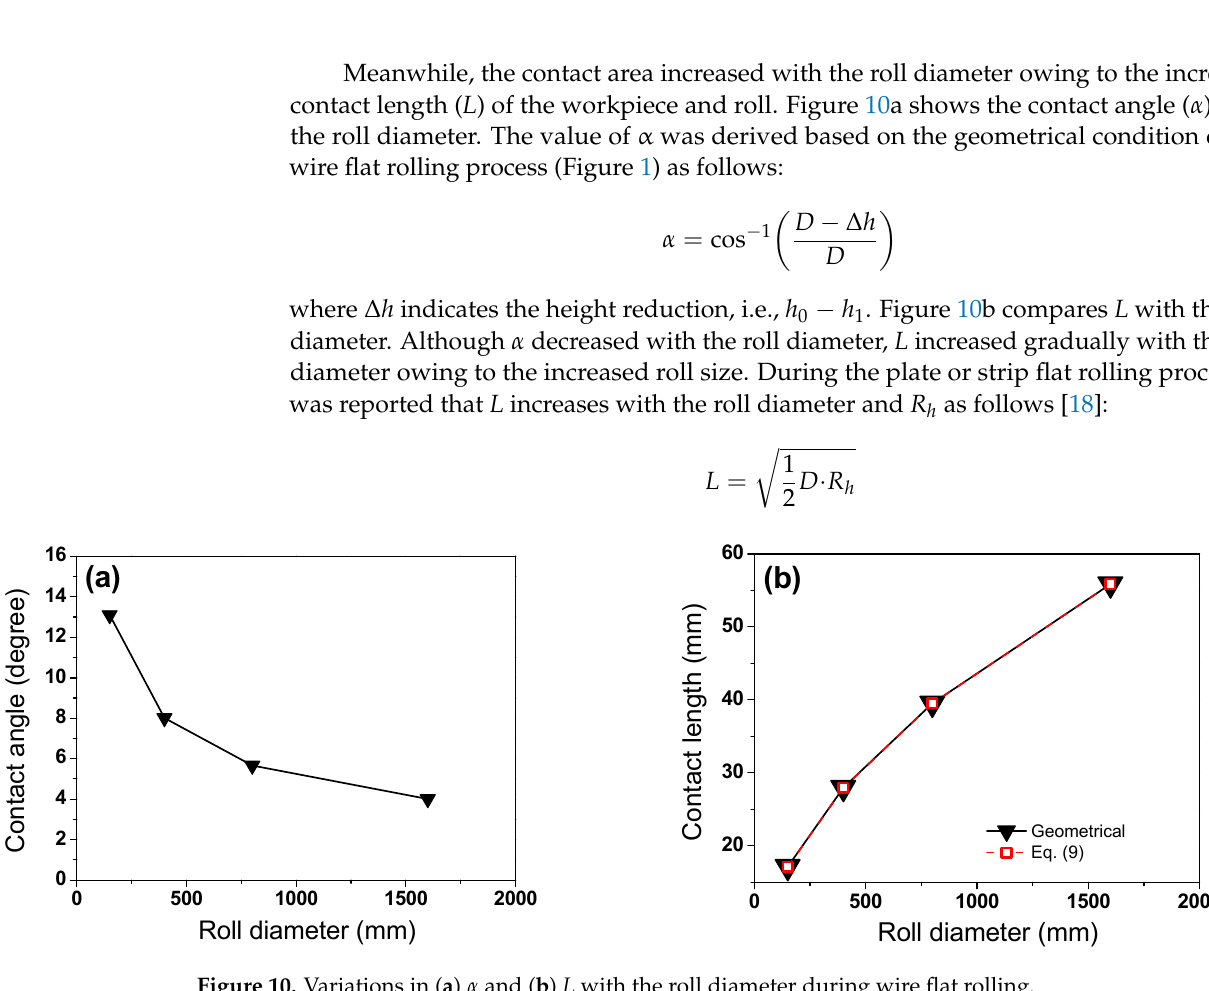
Figure 11. Comparison of the ( a ) contour of the damage value in the wire, ( b ) profile of the damage value along the hor- izontal direction, and ( c ) the maximum damage value at free surface and center regions with the roll diameter.